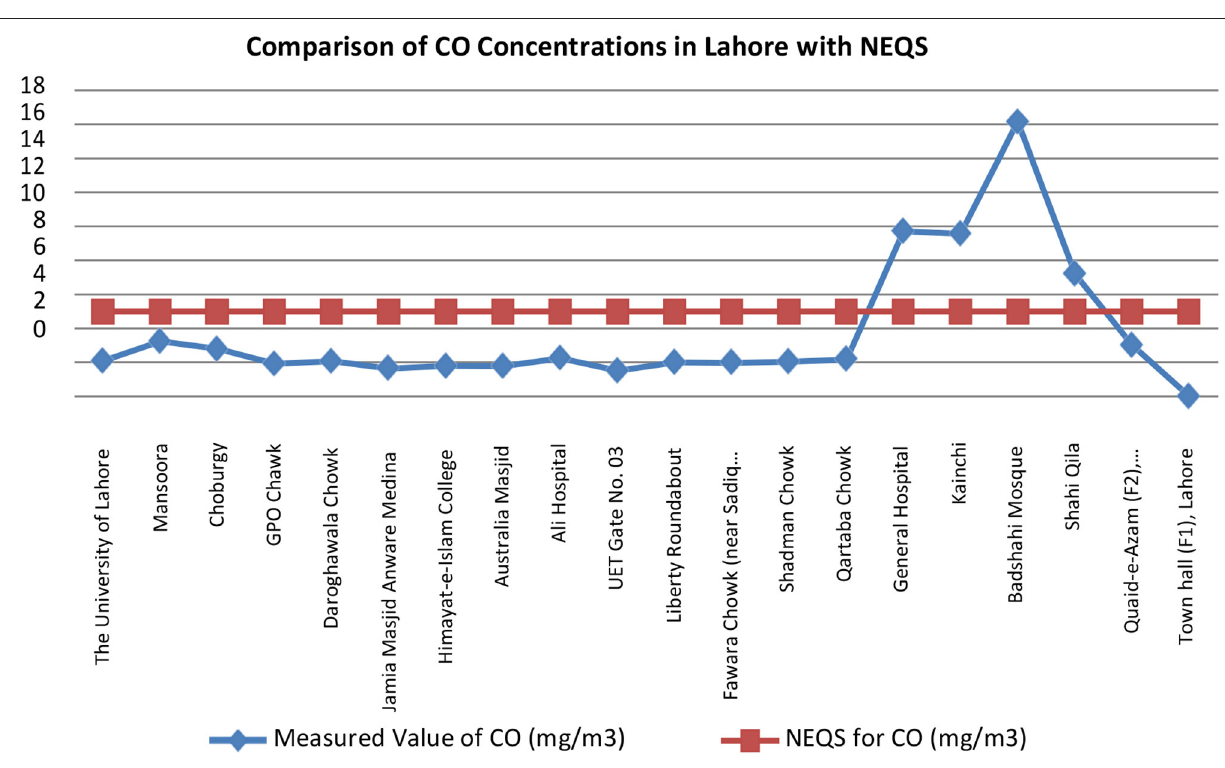
FIGURE 5 | Comparison of CO concentrations in Lahore with